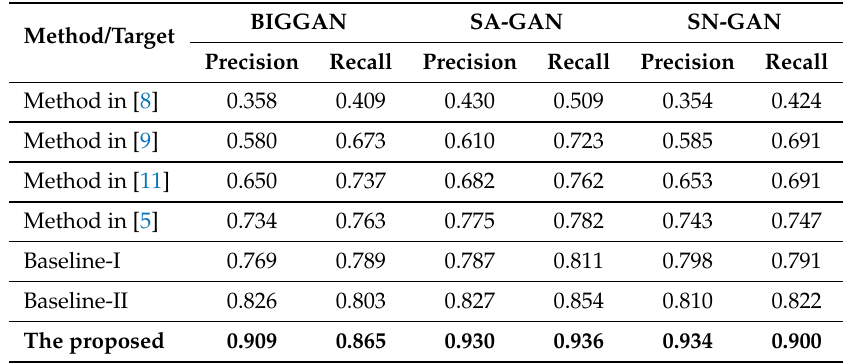
Table 4. The subjective performance comparison of the proposed and other fake general image